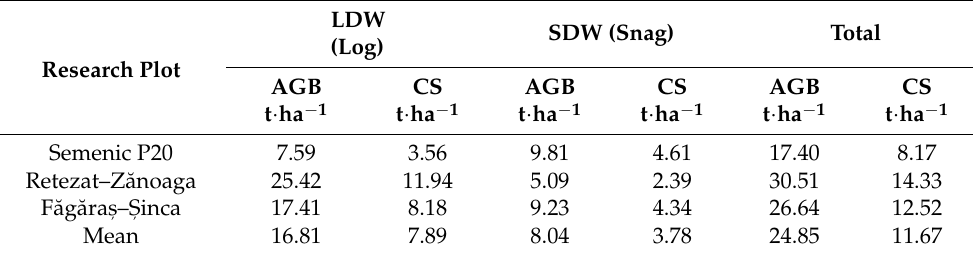
Table 6. Quantity of AGB and CS in relation with